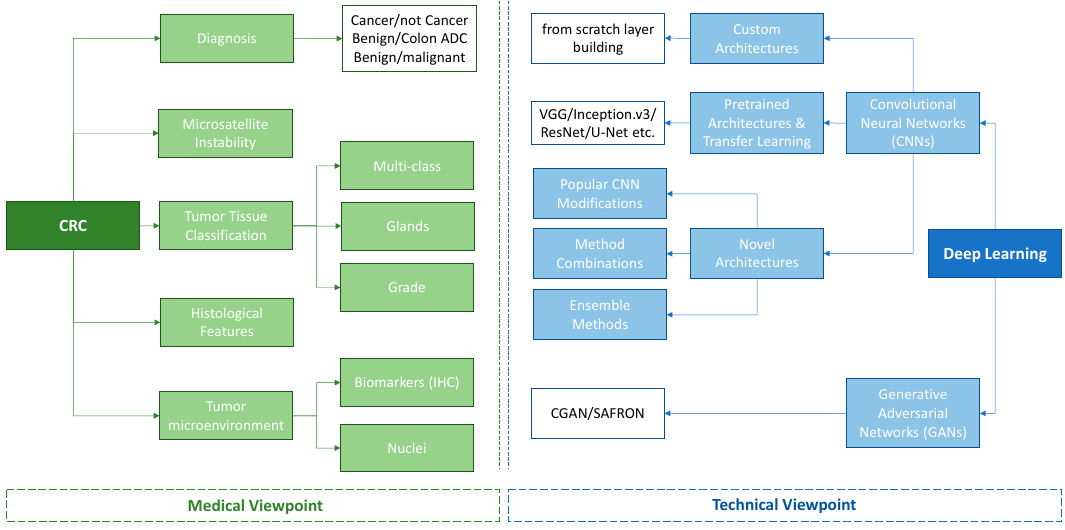
Figure 3. Tree diagram for the categorization of the studies.